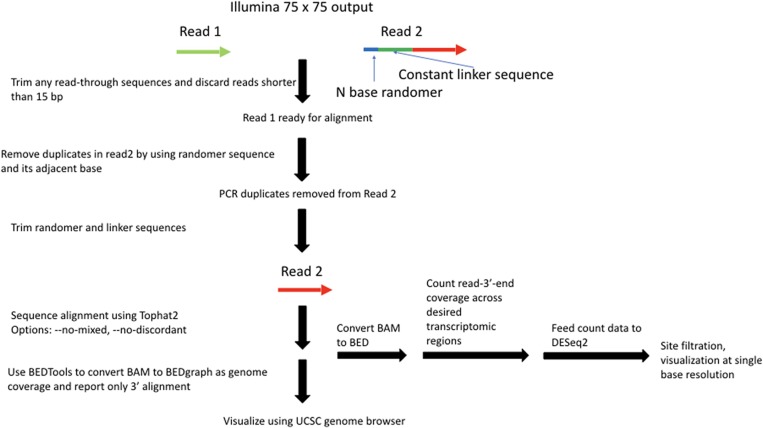
RibOxi-seq data processing and analysis pipeline.